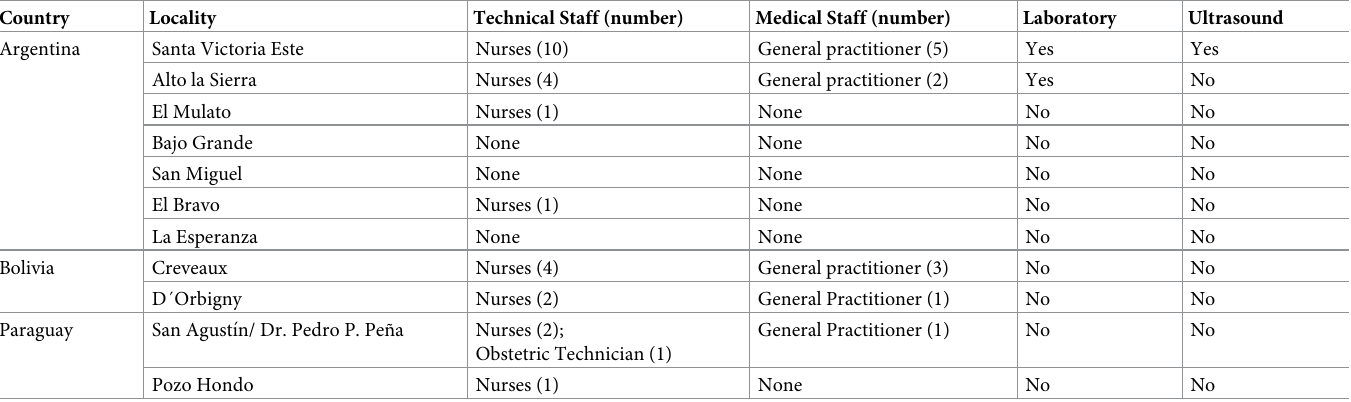
Table 1. Characteristics of the different health centers in the different localities within each country with respect to their medical staff, laboratory, and presence of an ultrasound machine. Country Locality Technical Staff (number) Medical Staff (number)